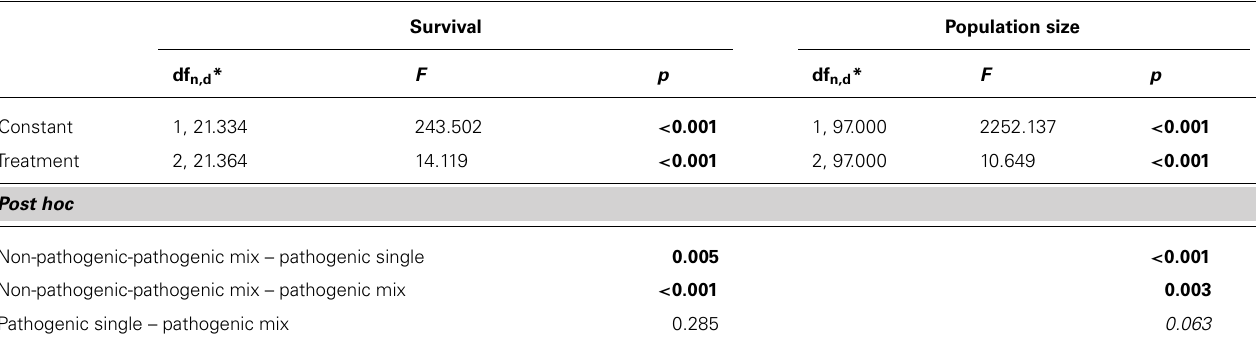
Table 2 | Statistical results of the comparison of the three pathogenic treatments (mixed non-pathogenic-pathogenic Bt, pure pathogenic Bt, mixed pathogenic Bt) using a general linear mixed model with treatment as fixed factor and strain combination(treatment) as random factor and a post hoc test (LSD).